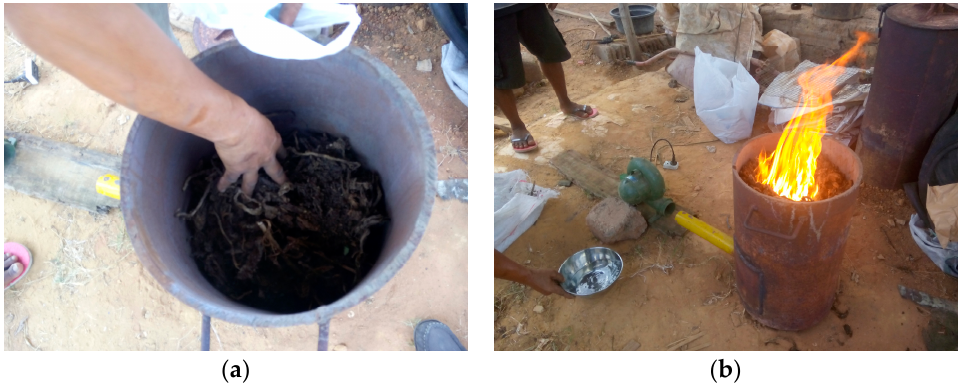
Figure 3. Loading the sun dried biomass into a steel drum ( a ) and burning the biomass to generate a plant ash ( b ). Table 3. Detail of the smelting process used to recover metal from the harvested biomass.